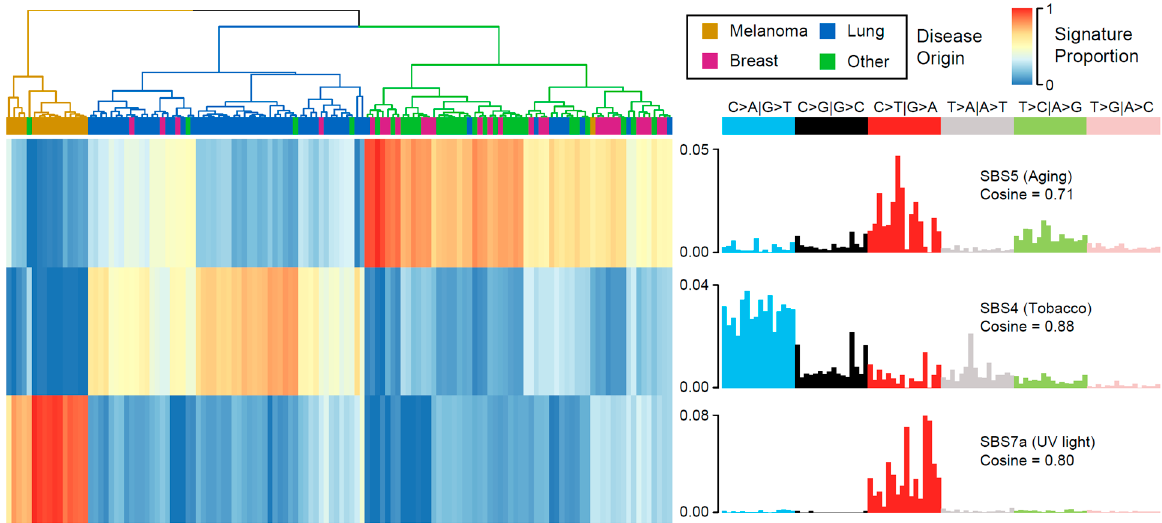
Figure 2. Mutational signatures detected in BM samples. Hierarchical clustering of the contribution of the three signatures suggests that most mutations were acquired before metastasis occurred, as they reflect the etiology of the primary disease (UV exposure for melanoma and tobacco exposure for lung cancers), with the remainder dominated by an age-related signature.